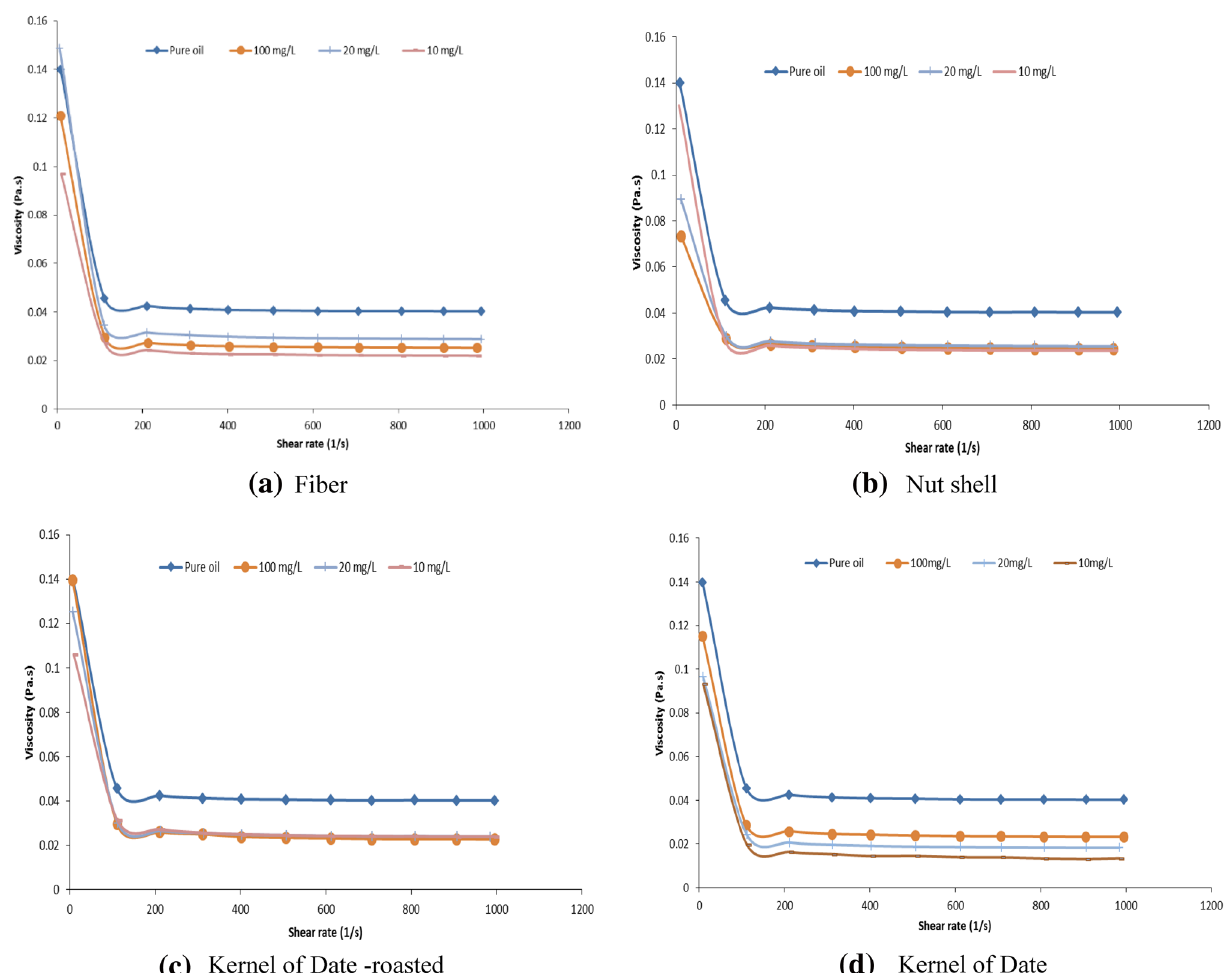
Fig. 3 Viscosity of light crude oil using bio materials (75